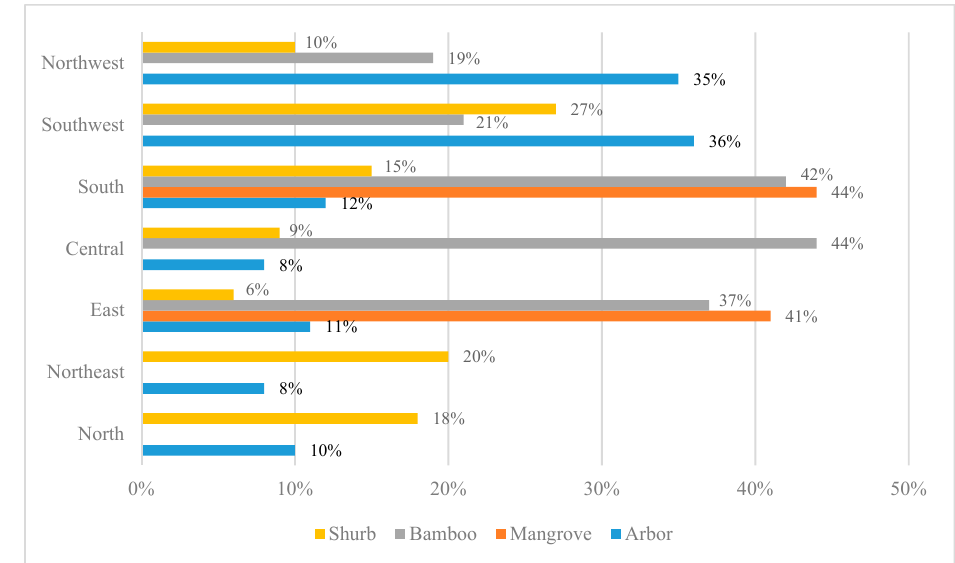
Figure 5. Distribution of L1 forest landscape in seven regions by area.